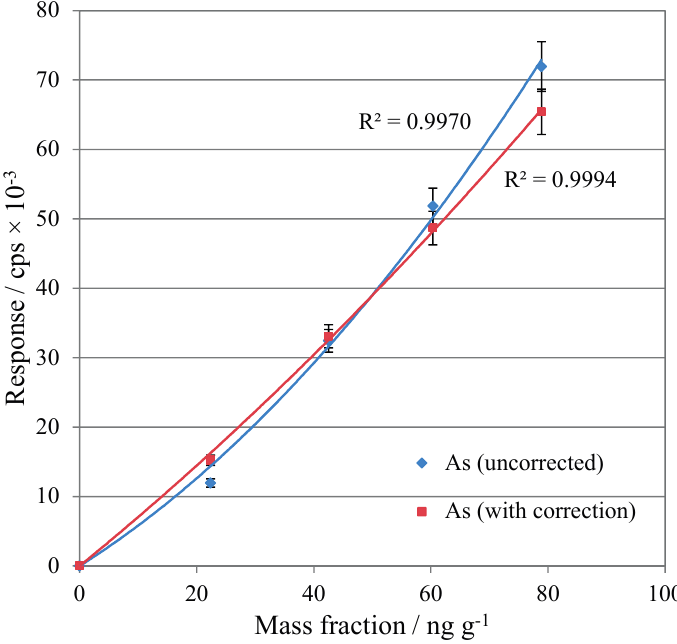
Figure 1. Arsenic calibrations with and without interference correction, response as counts per second (cps) × 10 − 3 . Calibration curves are fitted second order polynomials. The errors bars represent the standard deviation of five repeat measurements of each